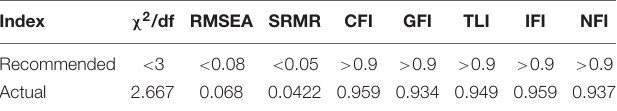
TABLE 4 | Confirmatory factor analysis of the overall model.